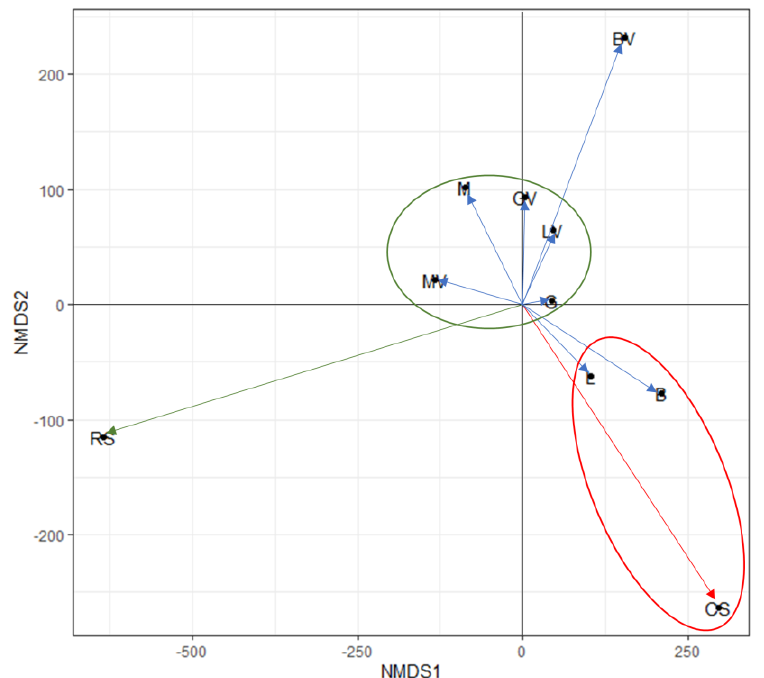
Figure 3. Non-metric multidimensional scaling (NMDS) for the different studied soils and treat- ments: the recovered soil (RS), the control polluted soil (CS), and the different studied amendments (B: Biopiles, G: Gypsum, L: Landfarming, M: Marble sludge; and the same with the addition of vermicompost (BV, GV, LV and MV)). The NMDS was carried out including the soil physicochemical properties; the total (Xx_T), bioavailable (Xx_B) and water-soluble (Xx_W) content of Cu, Zn, As, Pb and Cd; and the results for the five performed ecotoxicological tests.